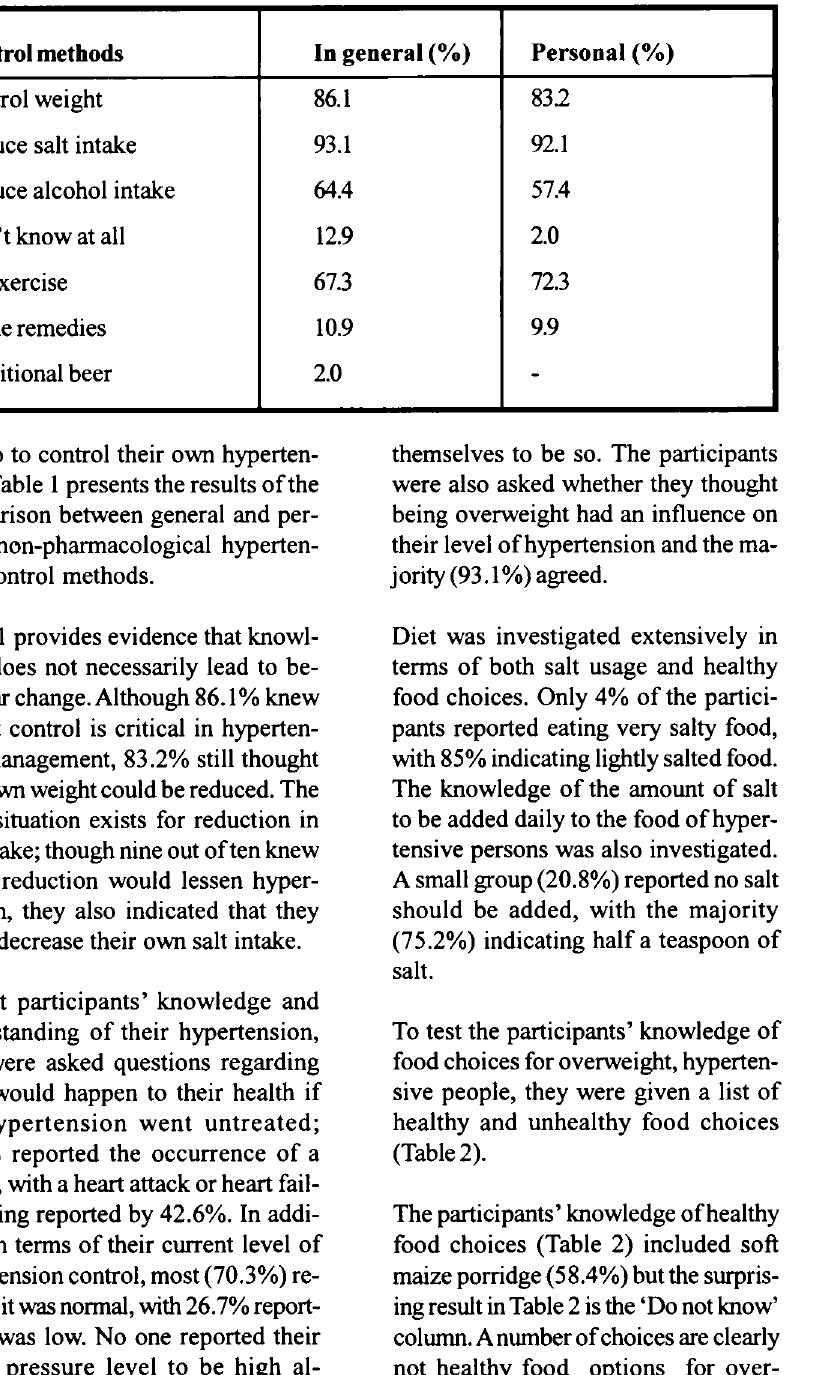
Table 1: Comparison between general and personal non- pharmacological hypertension control methods